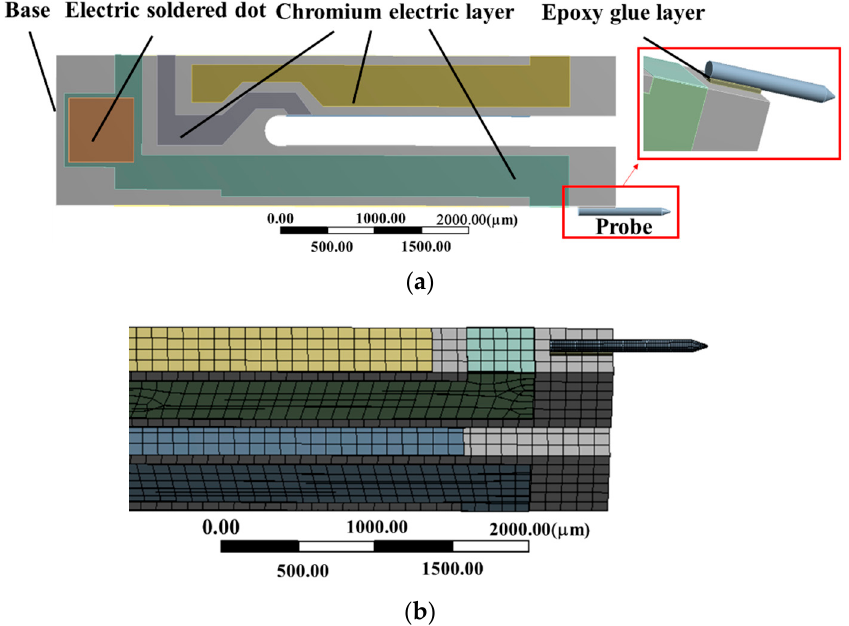
Figure 4. ( a ) QTF-probe and ( b ) meshing map in the numerical calculation.